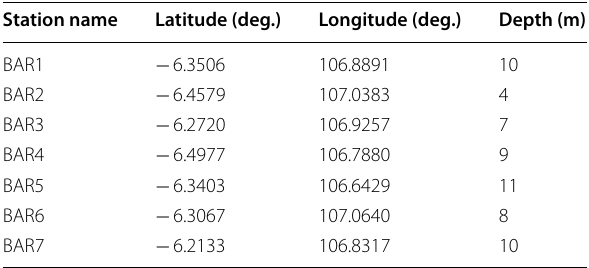
Table 1 The location of seven borehole stations used in this